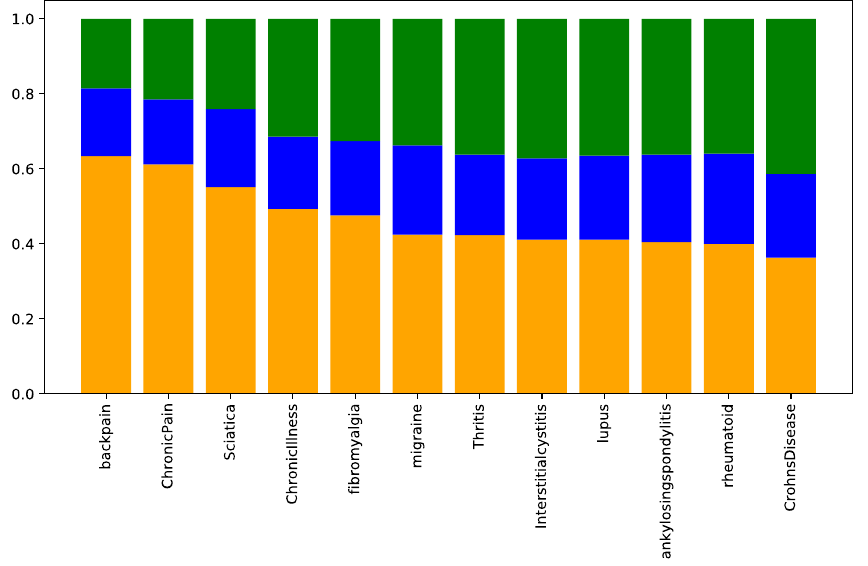
Figure A10. Ratio of negative (orange), neutral (blue), and positive (green) sentiment documents per subreddit.